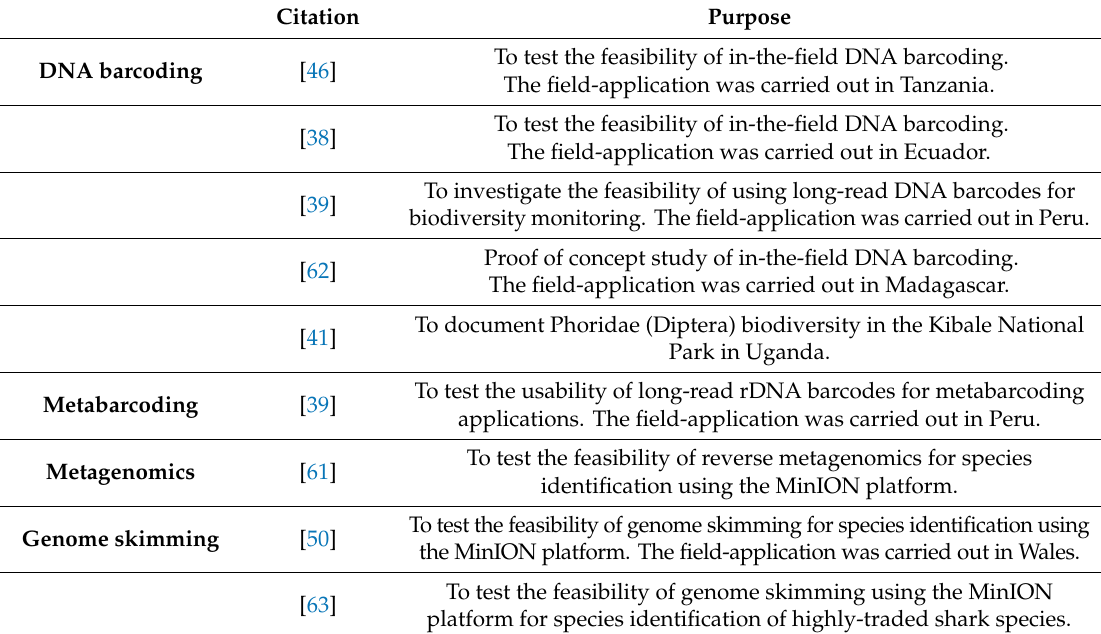
Table 1. Applications of the MinION sequencing platform for biomonitoring of higher eukaryote